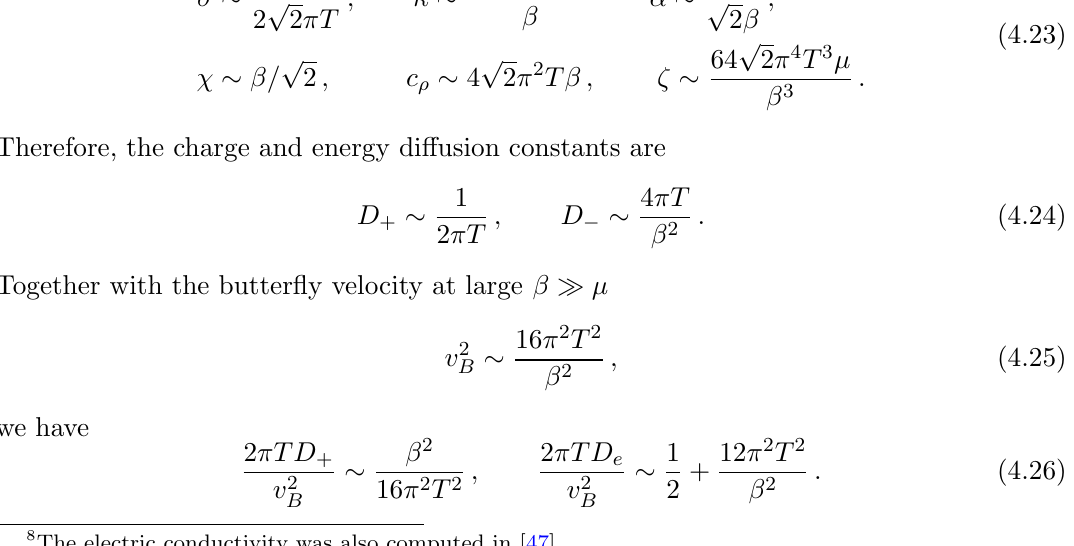
( (cid:22) 6 = 0) there are two branches, positive Q and negative Q , as explained in (4.9)